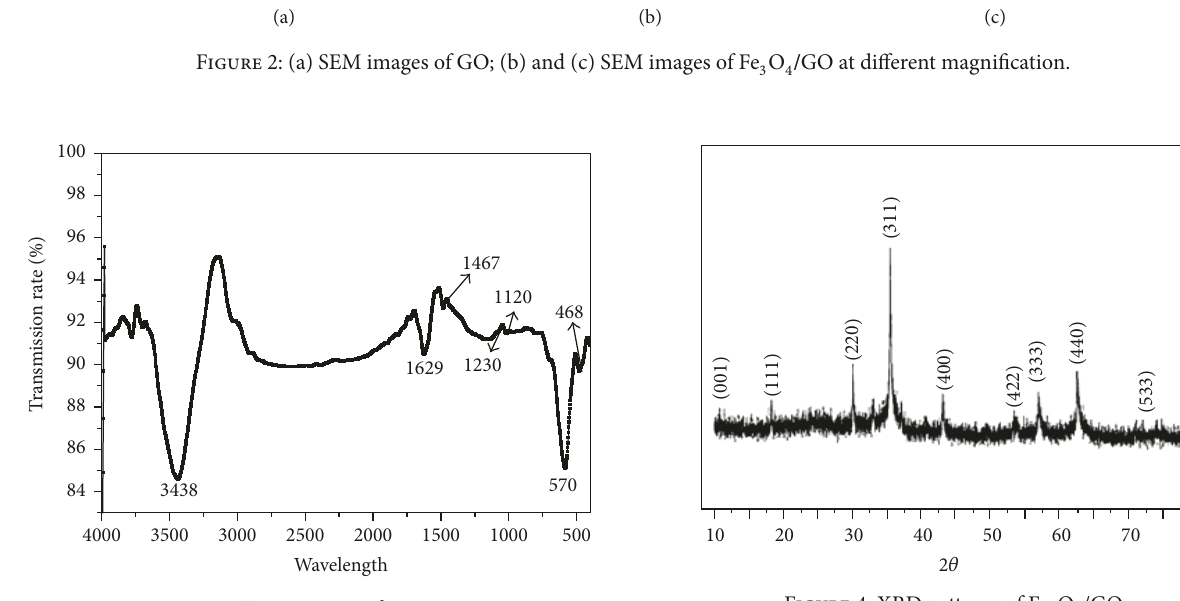
Figure 3: FT-IR patterns of Fe 3 O 4 /GO. Figure 4: XRD patterns of Fe 3 O 4